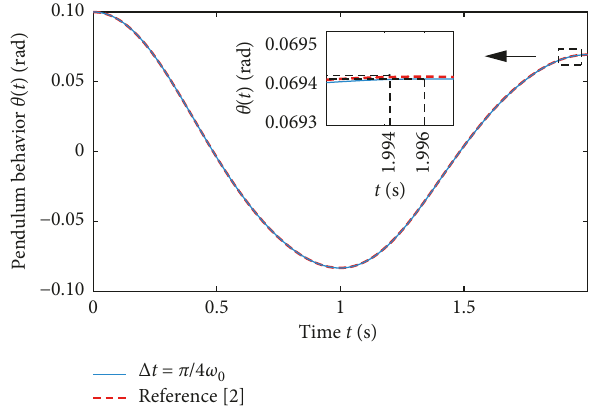
Figure 6: The comparison of the pendulum behavior (the first